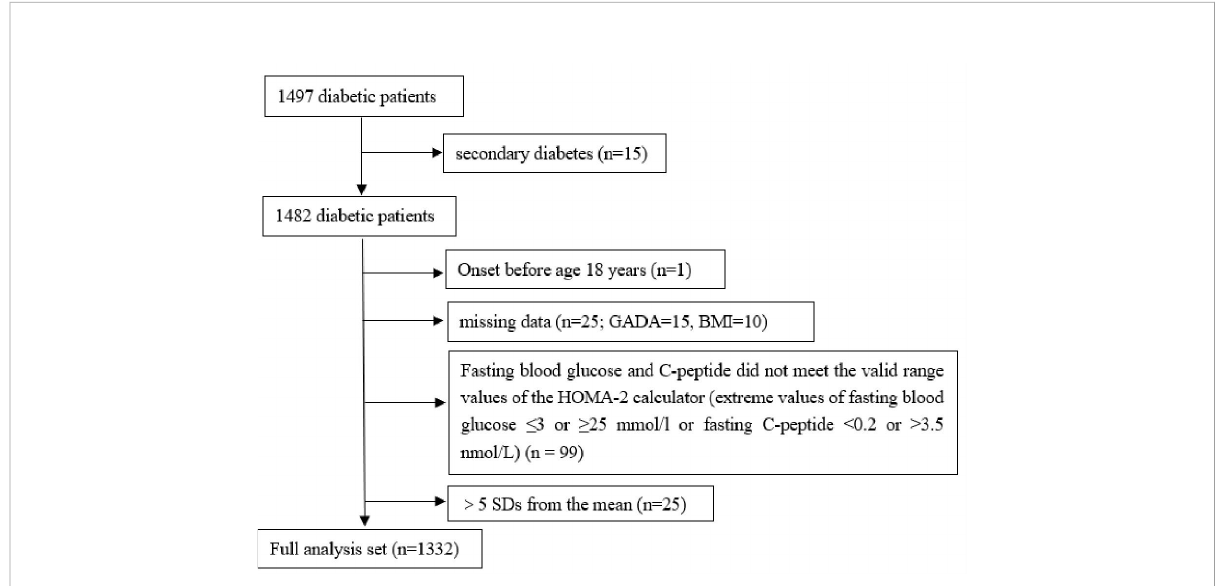
FIGURE 1 Flowchart of study participants. GADA, glutamate decarboxylase antbody; BMI, body mass index; HOMA, homeostatic model assesment; SD, standard